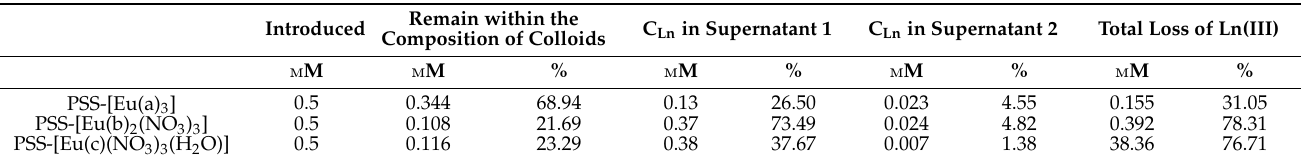
Table 3. The equilibrium Eu 3+ concentrations in the aqueous colloids and the supernatants after the phase separation and the washing procedure along with the percentage of Eu 3+ in the colloids and